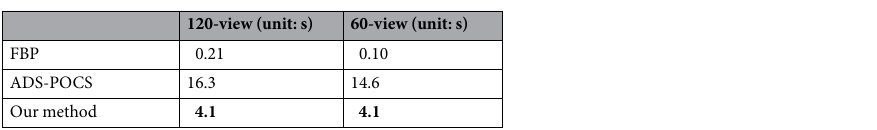
Table 4. Time consumption of different methods.